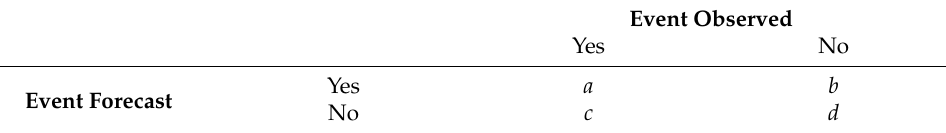
Table 2. A 2 × 2 contingency table of observed and forecast